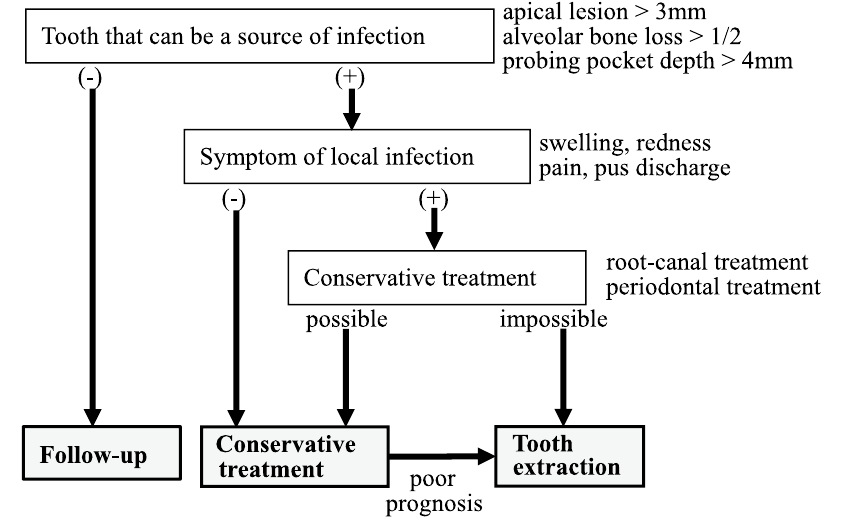
Figure 3. Schema for dental intervention in patients receiving high-dose